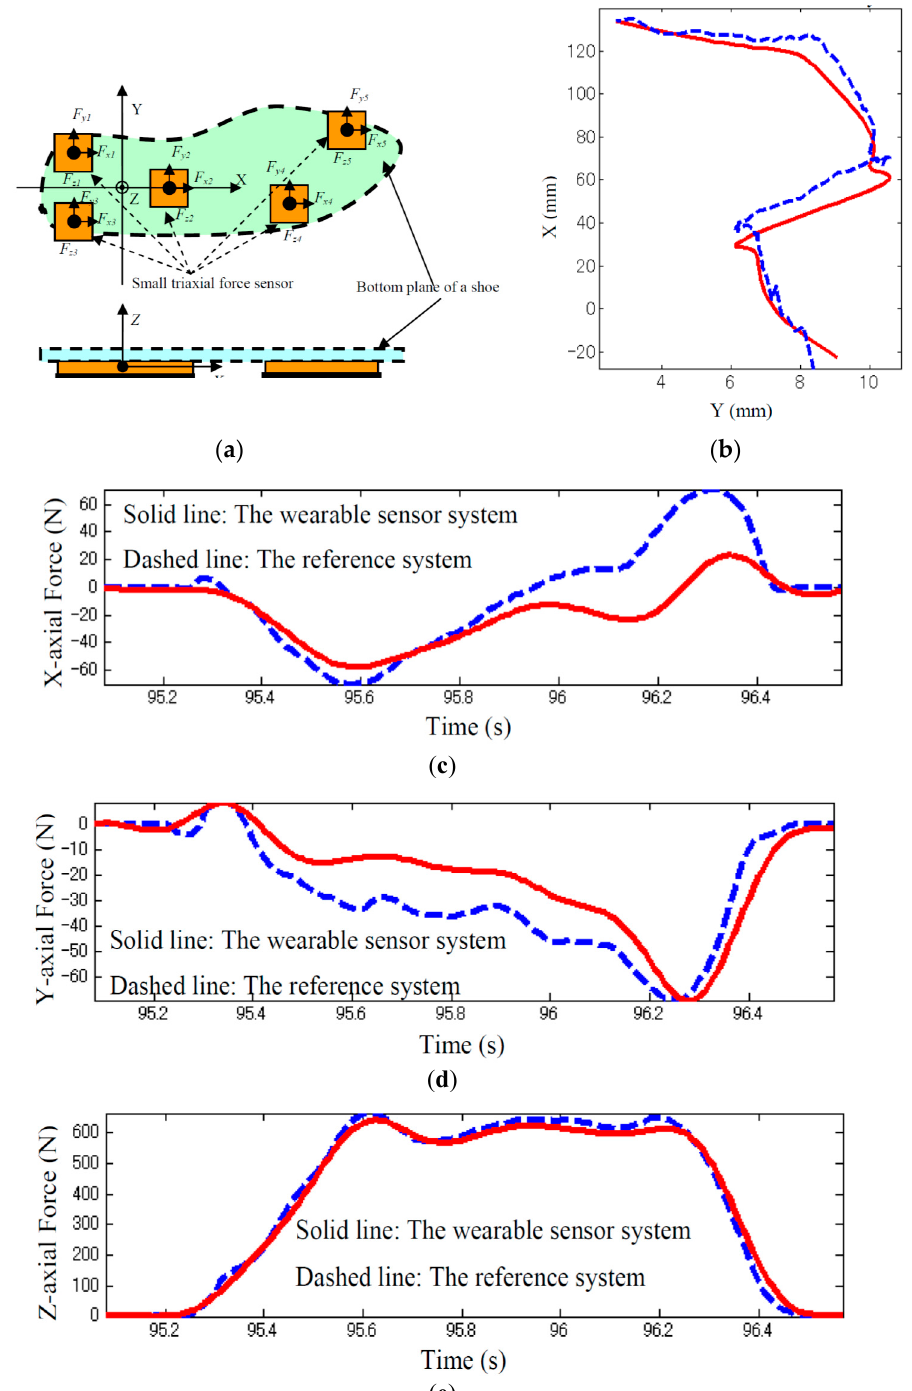
Figure 18. Instrumented shoe developed by Liu, et al. [95]. ( a ) Sensor layout; ( b ) (cid:1829)(cid:1867)(cid:1842)((cid:1872)) ; ( c ) (cid:1833)(cid:1844)(cid:1832) (cid:3028)(cid:3043) ((cid:1872)) ; ( d ) (cid:1833)(cid:1844)(cid:1832) (cid:3040)(cid:3039) ((cid:1872)) ; ( e ) (cid:1833)(cid:1844)(cid:1832) (cid:3049) ((cid:1872)) . ( d ) GRF ml ( t ) ; ( e ) GRF v ( t )